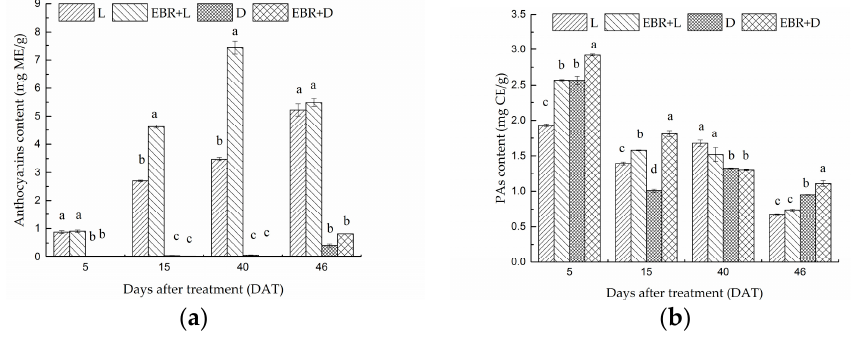
Figure 3. ( a ) Accumulation of anthocyanins per gram of skins dry weight in berry skins (cv. Cabernet Sauvignon) during development. The amounts are expressed as milligrams of cyanidin-3-monoglucoside equivalence (ME) per gram of dry berry skins (mg ME/g); ( b ) Accumulation of proanthocyanidins (PAs) per gram of skins dry weight in grape berries (cv. Cabernet Sauvignon) during development. The amounts are expressed as milligrams (+)-catechin equivalence (CE) per gram of dry berry skins (mg CE/g) (mean ± SE; n = 3). The different letters (a, b, c, d) indicate significant differences between treatments at p < 0.05 (Duncan’s multiple range test).